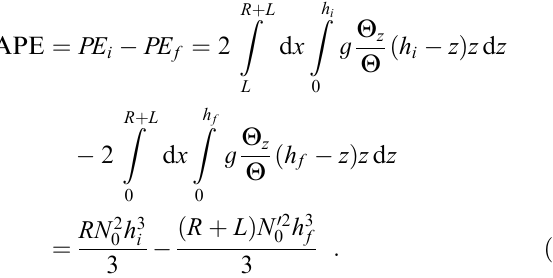
; N 0 are the initial and the final Brunt-Vaisala Here N 0 0 and H 0 are the initial frequencies, respectively, and H z z and final vertical potential temperature gradients, re- spectively. The final configuration and the final Brunt- Vaisala frequency are determined by mass conservation and by thermodynamics: